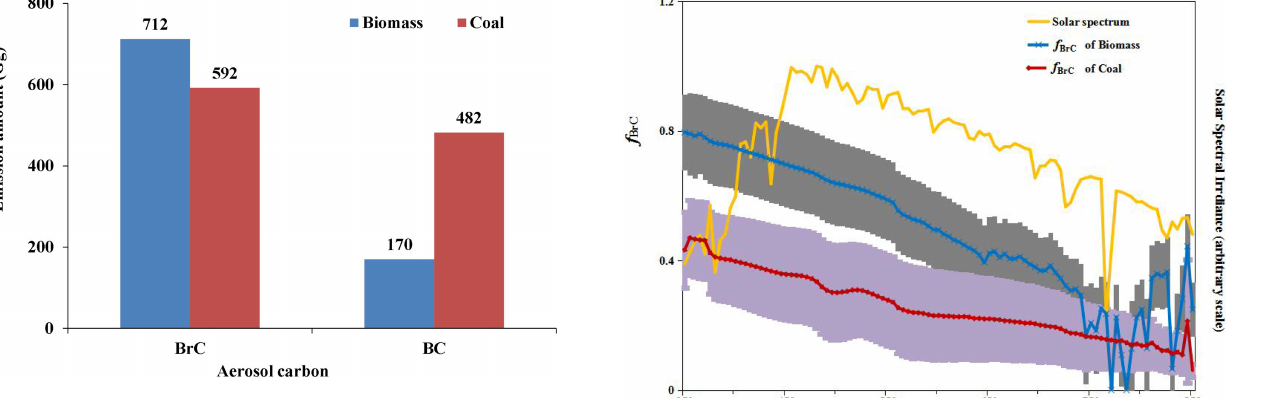
Figure 3. Comparison of BrC and BC emissions between biomass burning and coal combustion from China’s household sector in 2013. Figure 4. Ratios of light absorption by BrC to total absorption by